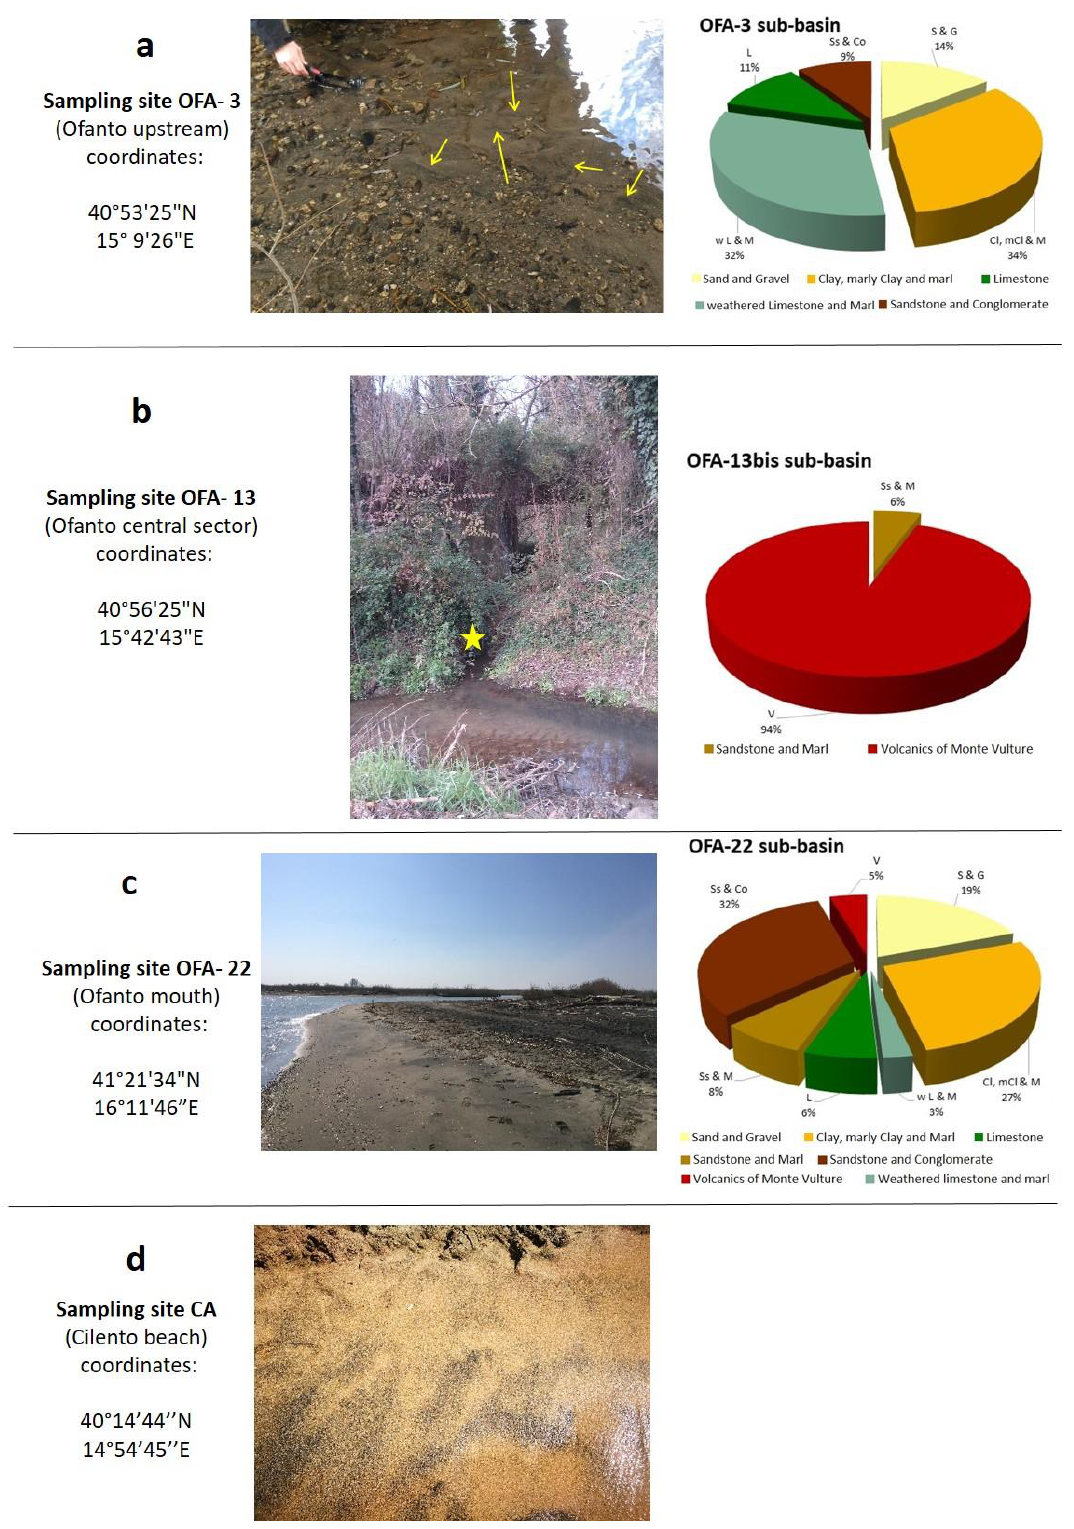
Figure 2. ( a ) Left: coordinates and picture of sampling site OFA-3. The yellow arrows indicate accumulation of dark minerals; right: percentages of the lithologies drained by the Ofanto River in the sub-basin feeding this sampling site (modified after [8]); ( b ) left: coordinates and picture of sampling site OFA-13bis. The yellow star indicates the site along the small tributary where the sample was picked up; right: percentages of the lithologies drained by the tributary in the sub-basin